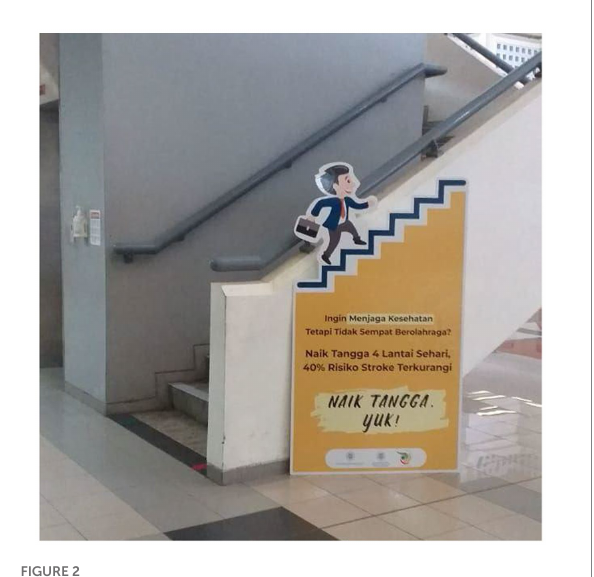
FIGURE 2 Placement and design of the